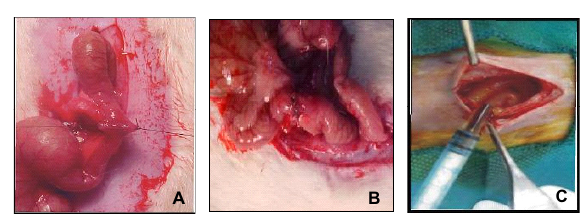
FIGURA 3 – Avaliação tensiométrica da anastomose. Nota: